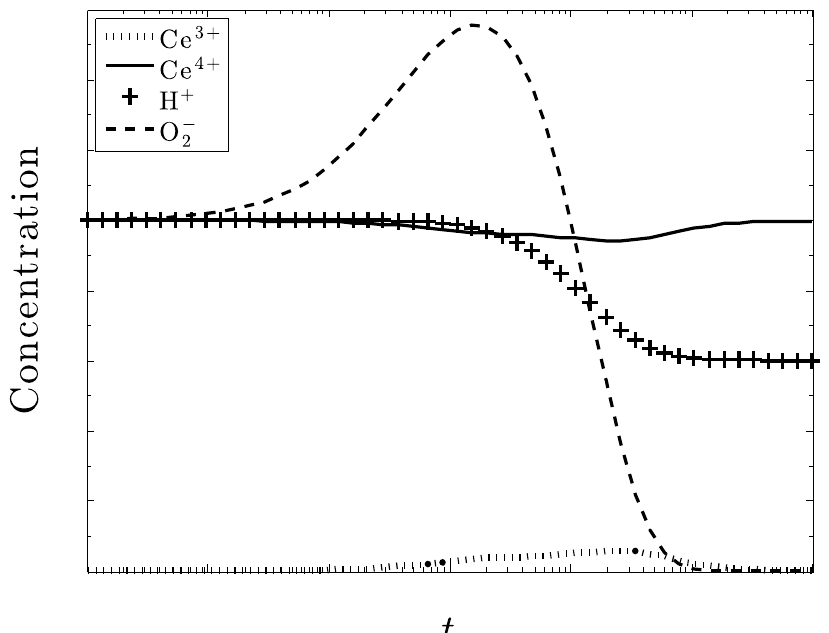
Figure 4. Now k 1 is fixed at five-times greater than k 2 , k 3 and k 4 . The other species concentrations are equal, and the system again starts out as CeO 2 .